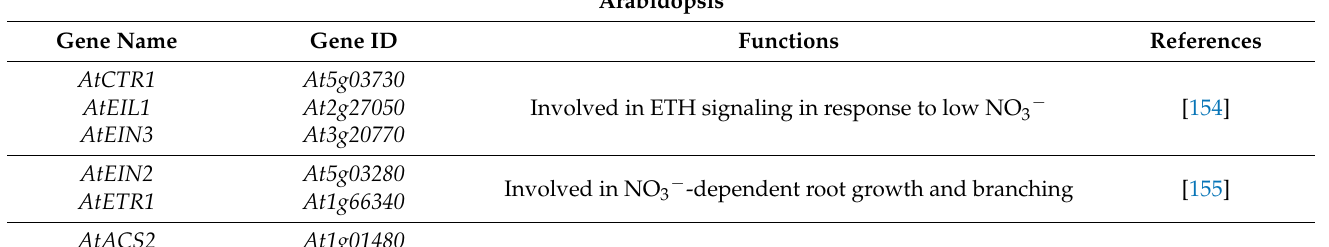
Table 4. List of genes and their roles associated with N stress and ETH in Arabidopsis.